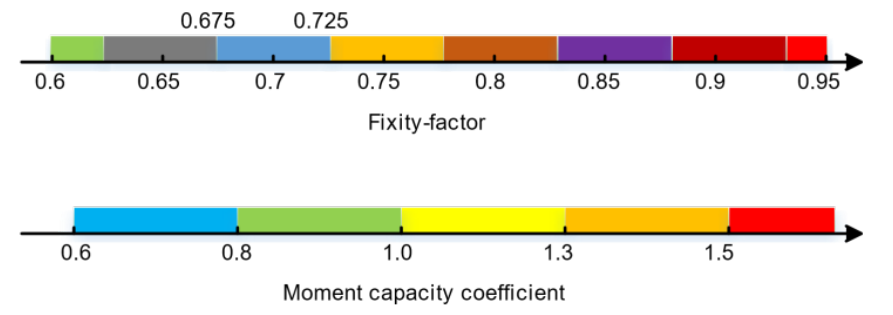
Figure 12. Performance segments of connections.